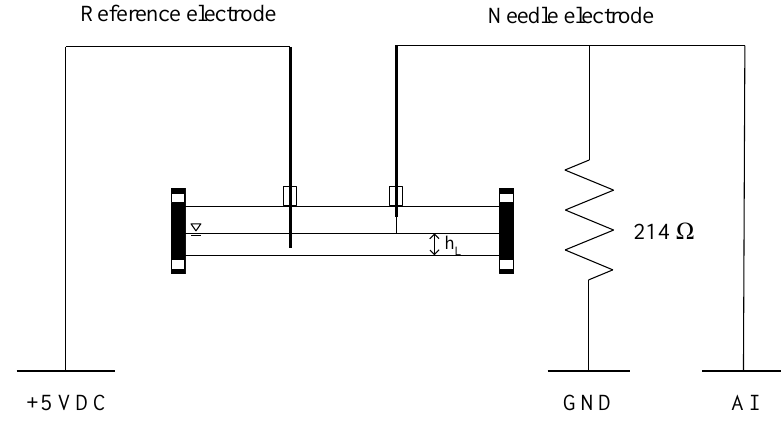
Figure 4. Resistive probe electrical scheme.